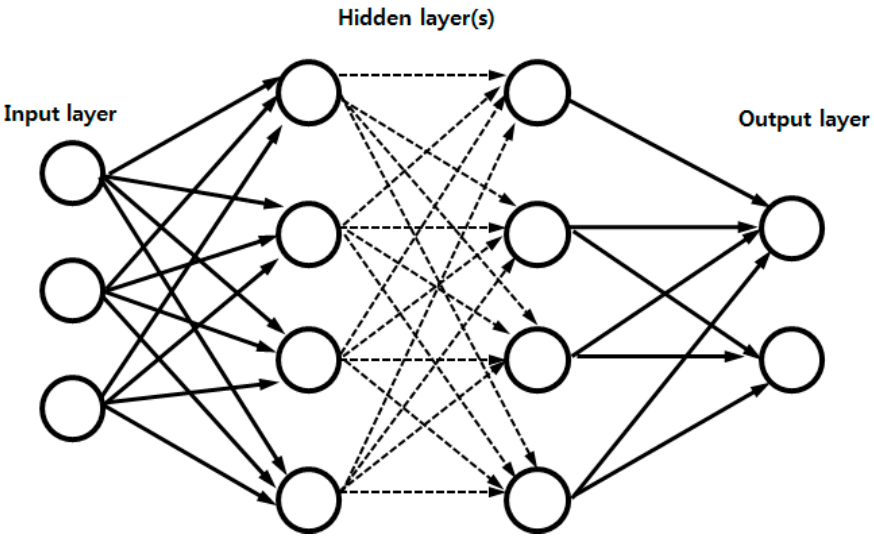
Figure 1. Conceptual structure of the deep neural network (DNN) model [22].